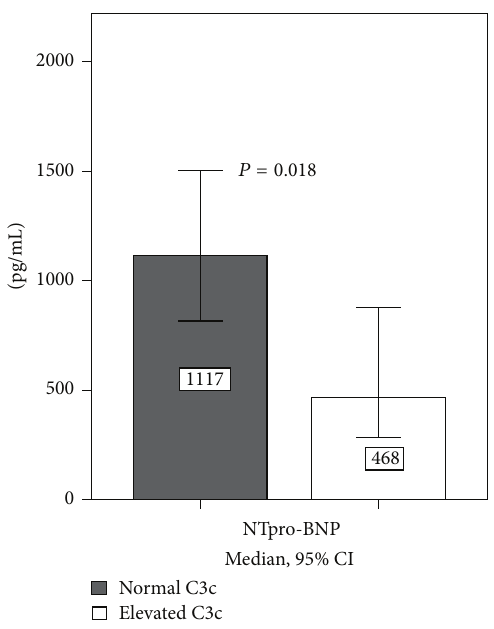
Figure 2: Comparison of NT-proBNP values in patients with normal versus elevated C3c values. Lower values of NTpro-BNP were found in patients with elevated C3c (468 [246; 1182]pg/mL versus 1117 [385; 2662]pg/mL; 𝑃 = 0.018 ). NT-proBNP: N-terminal prohormone of brain natriuretic